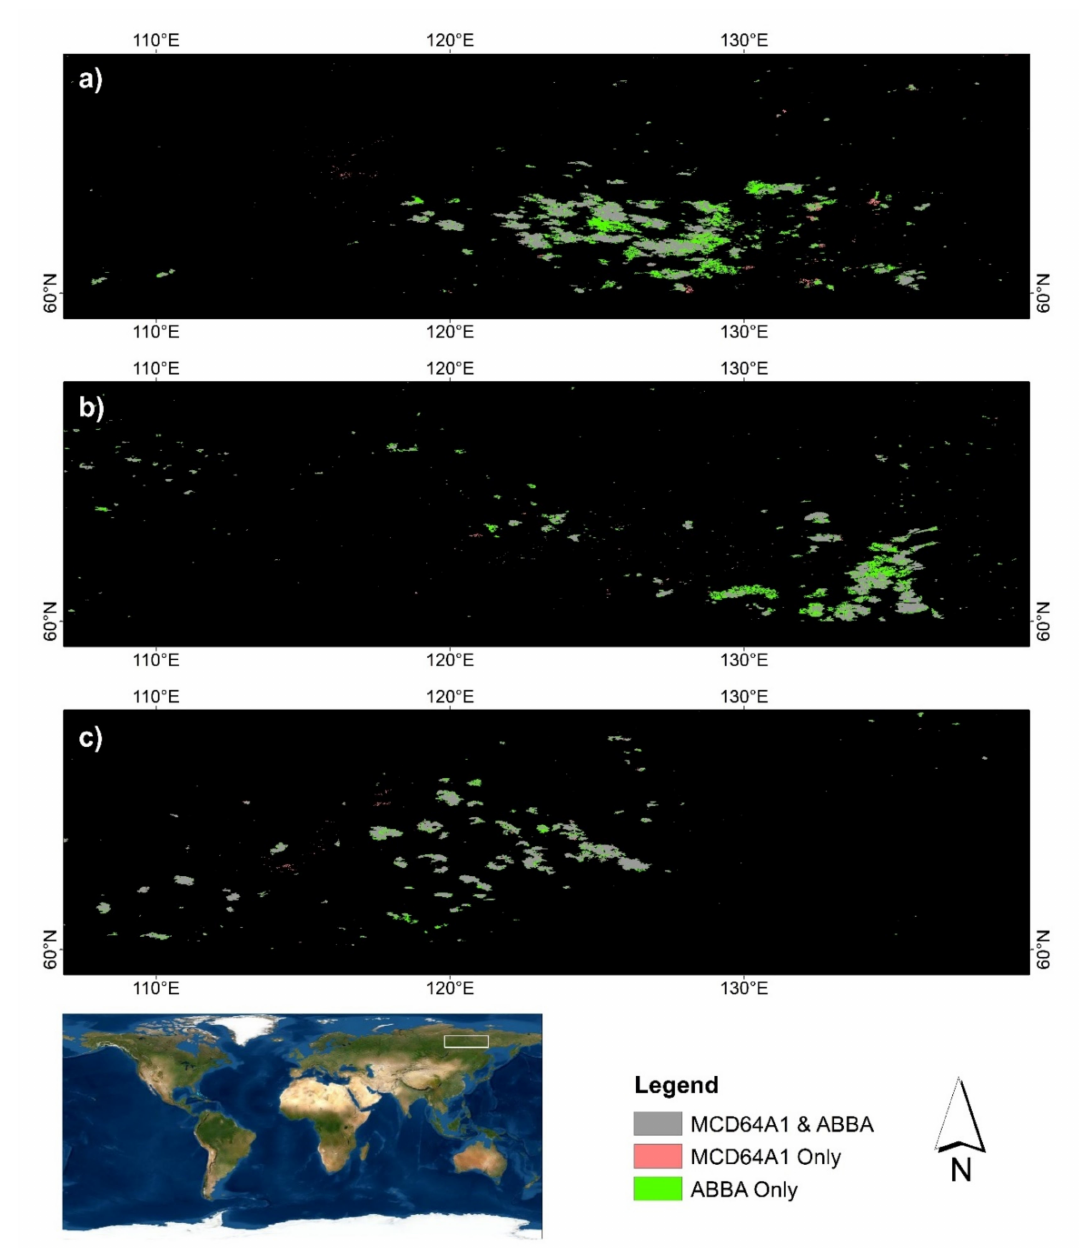
Figure 10. Close-up views of the differences in burned areas mapped by MCD64A1 and ABBA in Eastern Siberia in ( a ) 2002, ( b ) 2012, and ( c ) 2014. Areas in gray indicate burned areas that are mapped by both MCD64A1 and ABBA. Areas in red and green indicate burned areas that are mapped only by MCD64A1 and only by ABBA,